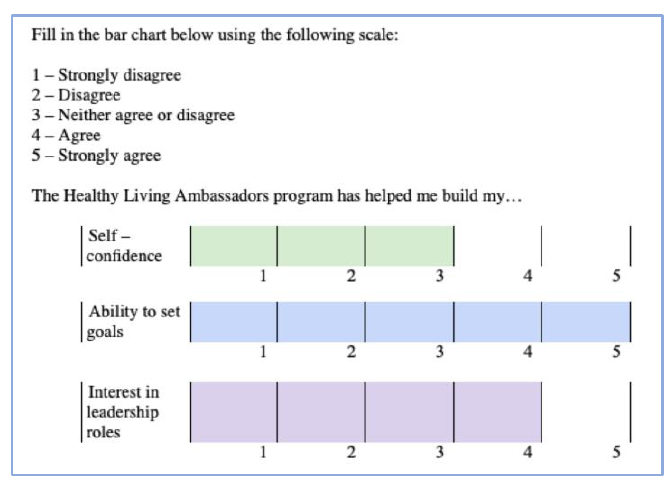
Figure 2. Example Filled-Out Bar Graph — Activity 8